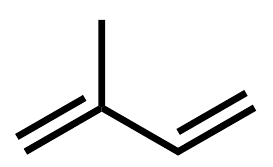
Figure 1. Isoprene unit.